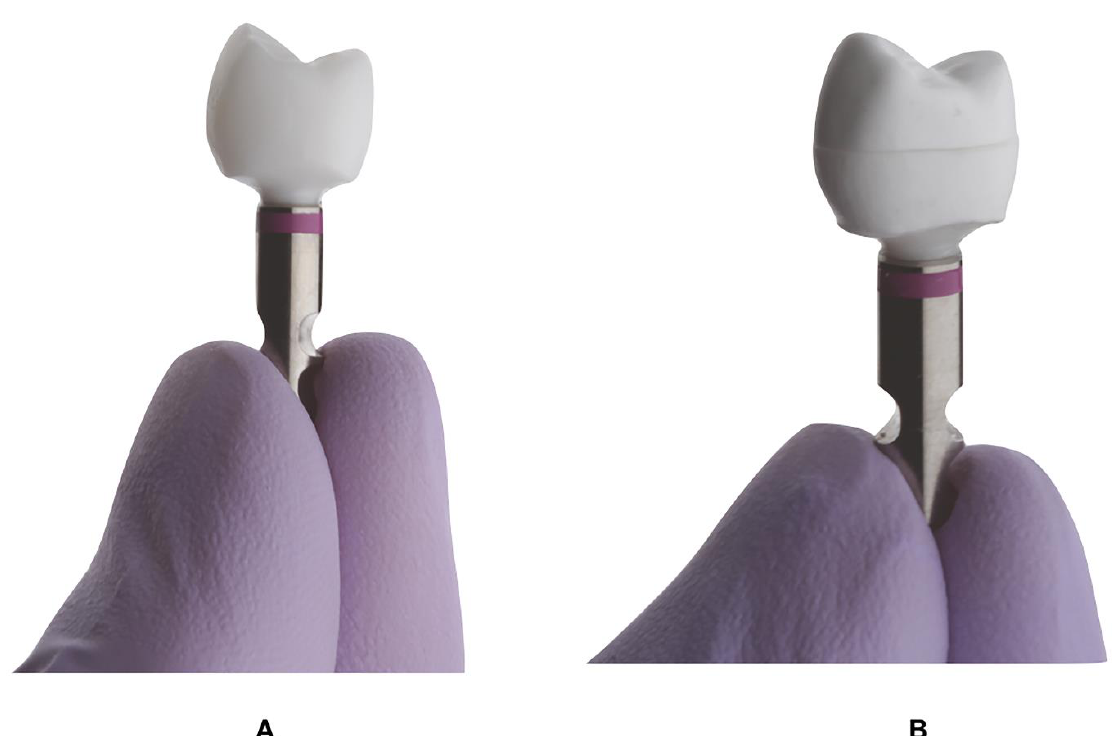
Figure 5. Crowns cemented to zirconia abutments before mechanical testing. ( A ), AM full contour Zirconia. ( B ), AM alumina toughened zirconia crown. Table 2. Characteristics of milled and stereolithography (SLA) additive manufactured (AM) zirconia specimens. Group